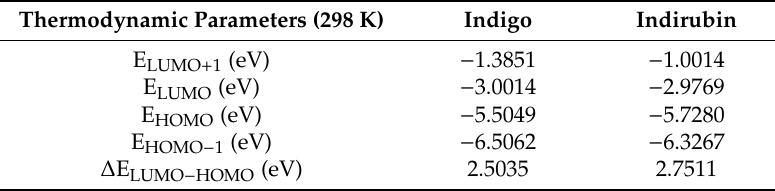
Table 2. Total molecular energy and frontier orbital energy.